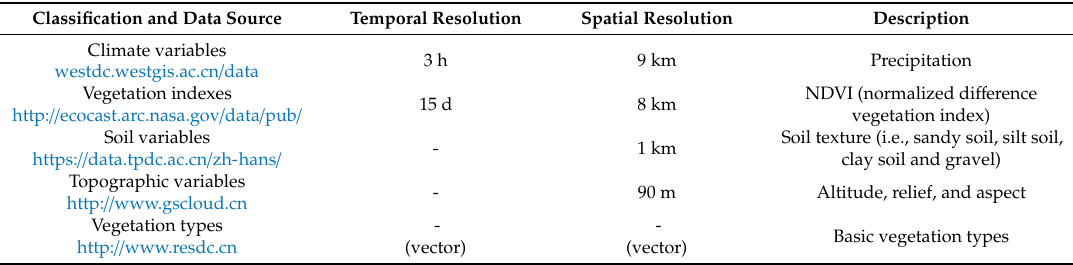
Table 1. Environmental variables used in the